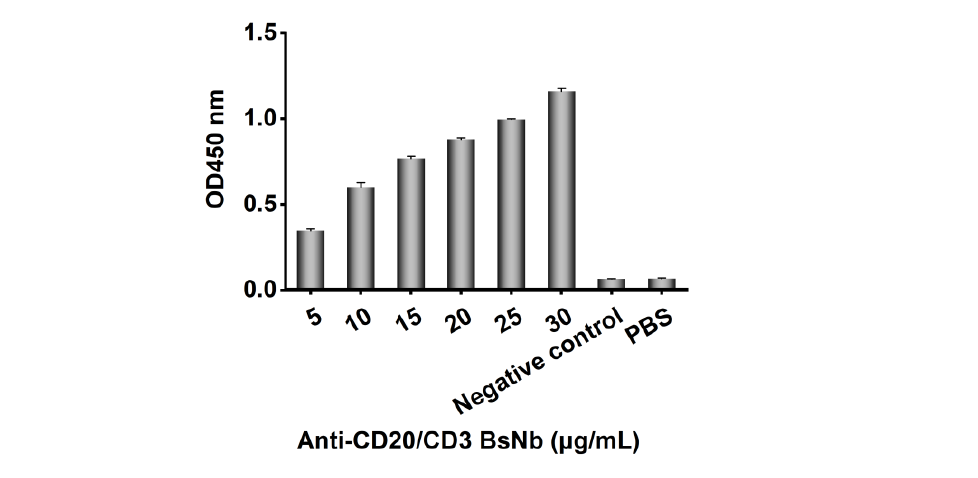
Figure 6. The binding activity of purified recombinant BsNb was measured by ELISA. The binding of recombinant BsNb to the CD20 polypeptide was detected with an HRP-conjugated 6 × His-tagged mouse monoclonal antibody. The pET-22bempty vector-transformed bacterial lysate was used as a negative control.